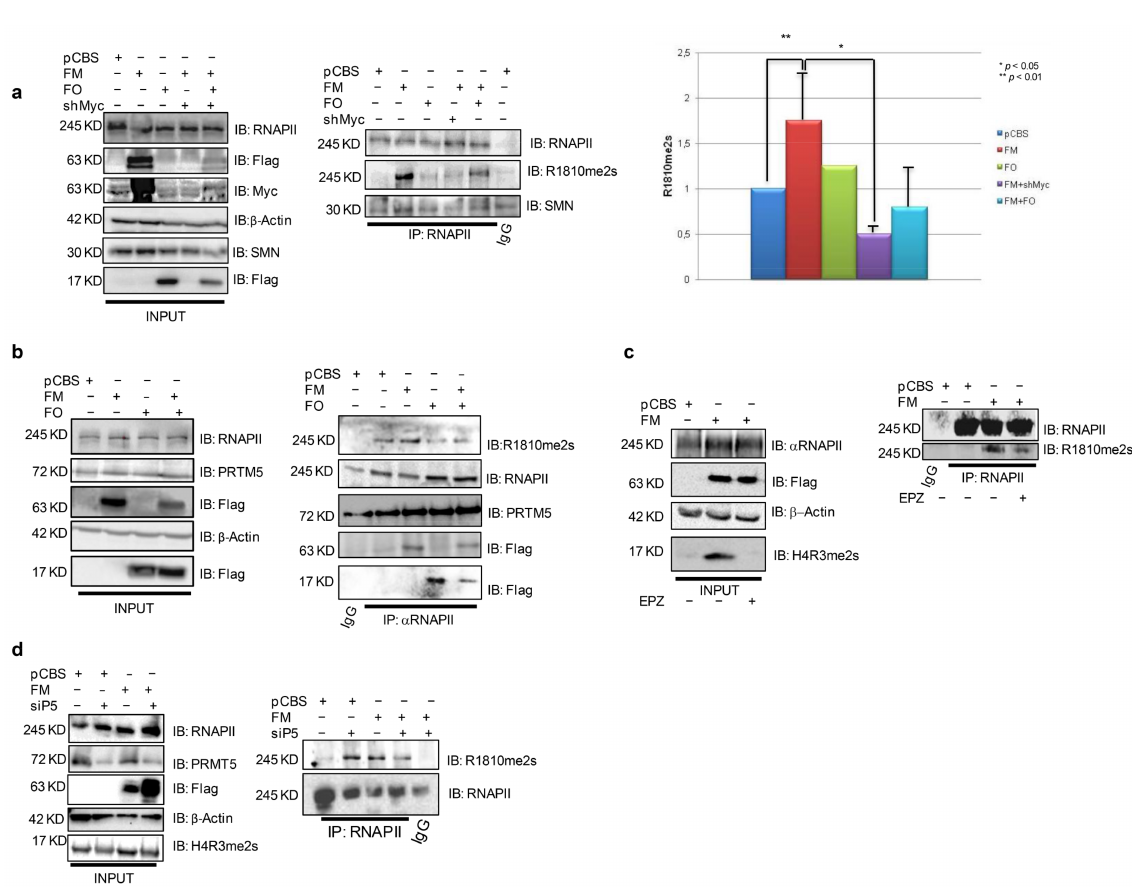
Figure 1. MYC ectopic expression enhances RNAPII R1810 symmetrical dimethylation via PRMT5. ( a ) Left: HEK293T cells transfected with pCBSFlagMYC, pCBSFlagOmomyc plasmids, and a shRNA against MYC, alone or in combination. Immunoprecipitations were performed by an RNAPII antibody. While ectopic MYC expression strongly increased RNAPII R1810 dimethylation, MYC shRNA and Omomyc inhibited such an increase (blots and densitometry histogram). ( b ): HEK293T cells transfected with pCBSFlagMYC and pCBSFlagOmomyc plasmids, alone or in combination. After 48 h, immunoprecipitations were performed by an RNAPII antibody. PRMT5, SMN, MYC, and Omomyc co-precipitated with RNAPII. ( c ) HEK293T: cells transfected with pCBSFlagMYC. The day after, cells were treated for 24 h with 5 µ M EPZ01566 PRMT5 inhibitor or control vehicle; thereafter, immunoprecipitation was performed. EPZ015666 impaired symmetrical dimethylation of H4R3 and the MYC-dependent increase of R1810me2s and H4R3me2s, the latter was used as a control of EPZ activity. ( d ) HEK293T cells transfected with a smart pool siRNAs for PRMT5 (siP5) and after 24 h transfected with pCBSFlagMYC plasmid. After, additional 48 h immunoprecipitation was performed. siP5 blunts MYC-dependent increase of R1810me2s. H4R3me2s decrease was used as control of PRMT5-impaired activity in the presence of siP5. Each bar in the histogram represents mean ± SEM. Abbreviations. FM: FlagMYC; FO: FlagOmomyc; EPZ: EPZ015666; siP5: